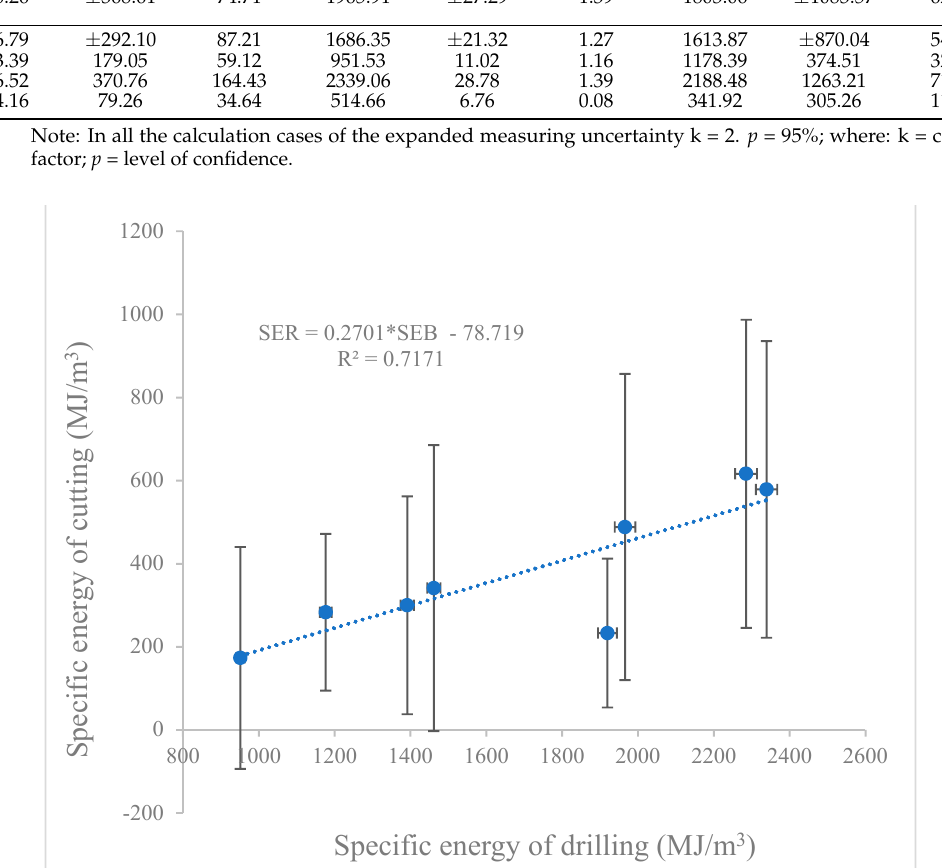
Figure 8. Diagram of the dependence of the specific rock cutting energy on the specific drilling en- ergy (measuring system with force and torque transducer) by groups. From Table 4, but also in Figures 7 and 8, it can be seen that the measurement uncer- tainty associated with the results of measuring the specific drilling energy obtained using the power measuring system is significantly less than the measurement uncertainties as- sociated with the results of measuring specific cutting or drilling energy obtained with the measuring system with force transducer or measuring system with force and torque meas- uring transducer. This indicates the quality of the measuring system. The increase in the